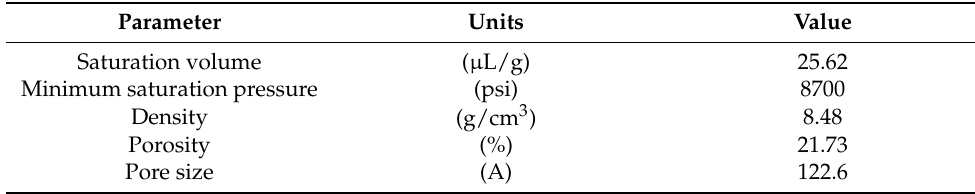
Table 2. Porosity determination